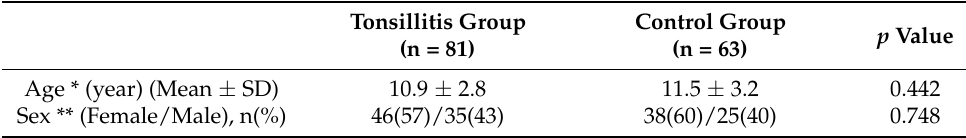
Table 1. Age and sex distribution of the participants.